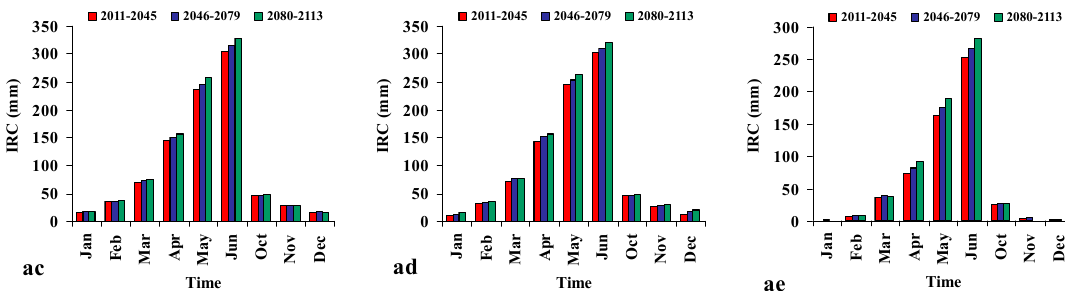
Figure 6. The net irrigation requirement of the wheat predicted from 2011 to 2113 under the A2 scenario. ( a = Ahwaz, b = Arak, c = Ardebil, d = Bandarabbas, e = Birjand, f = Bojnoord, g = Booshehr, h = Esfahan, i = Ghazvin, j = Ghom, k = Gorgan, l = Hamedan, m = Ilam, n = Karaj, o = Kerman, p = Kermanshah, q = Khoramabad, r = Mashhad, s = Oroomie, t = Rasht, u = Sanandaj, v = Semnan, w = Shahrekord, x = Shiraz, y = Tabriz, z = Tehran, ab = Ysooj, ac = Yazd, ad = Zahedan, ae = Zanjan).